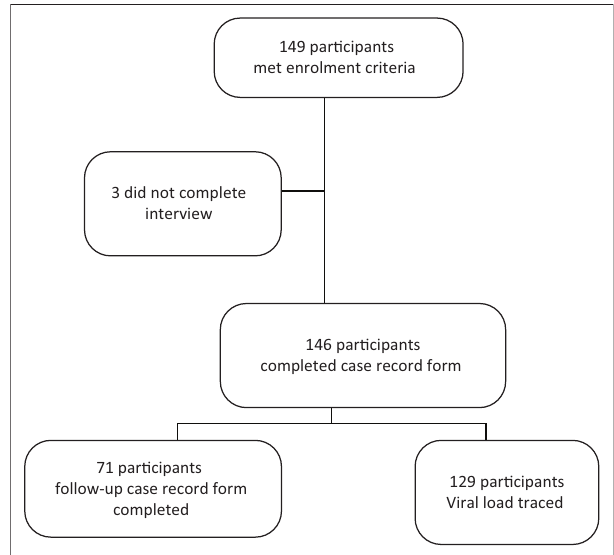
FIGURE 1: Flow diagram showing enrolment and